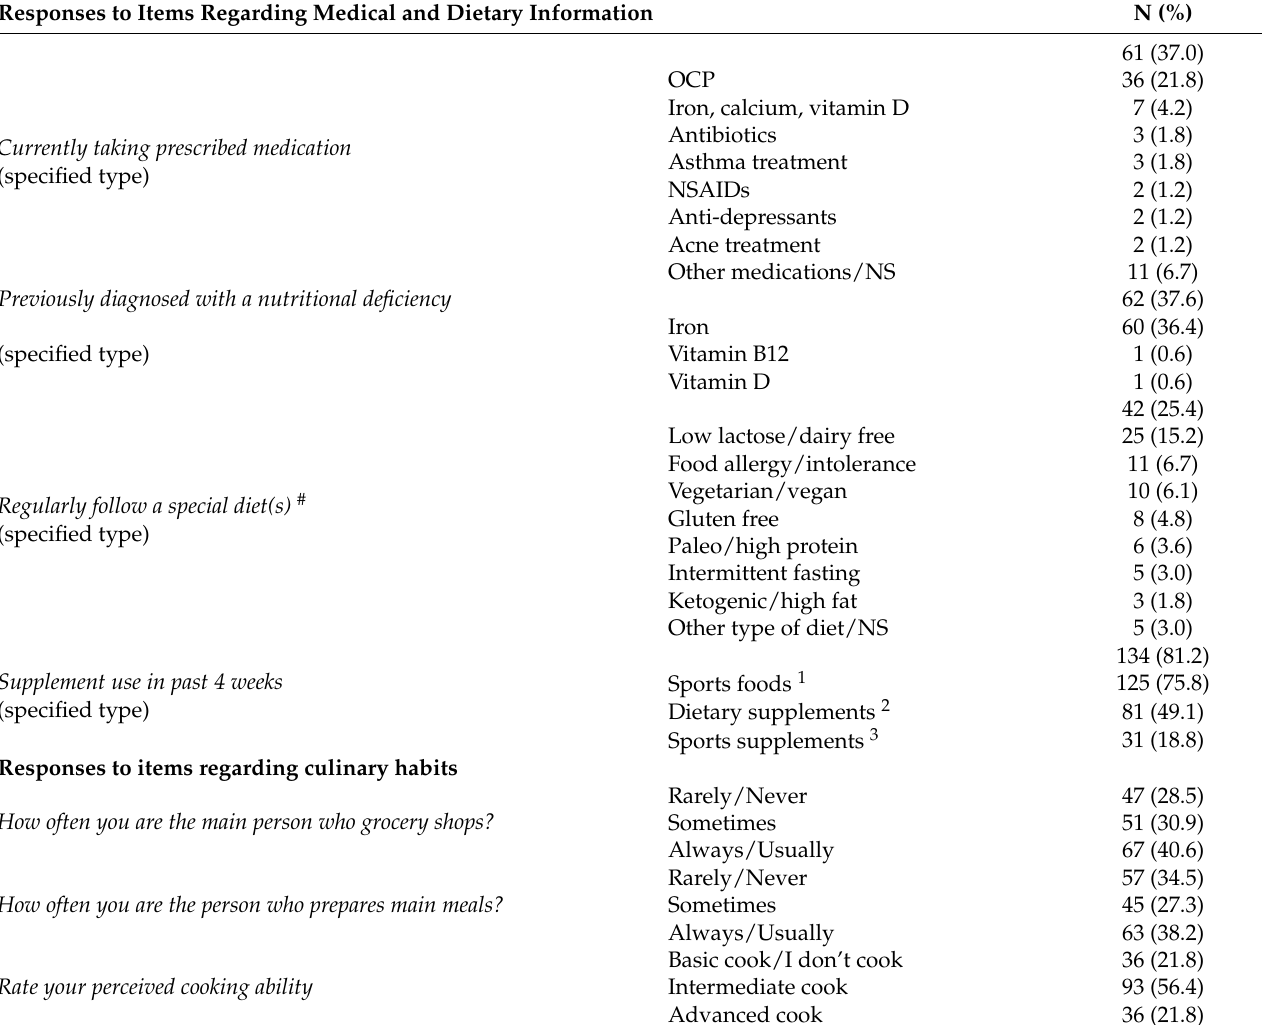
Table 2. Overview of non-scored ADI responses including medical and dietary information, sport and dietary supplement use, plus culinary habits.